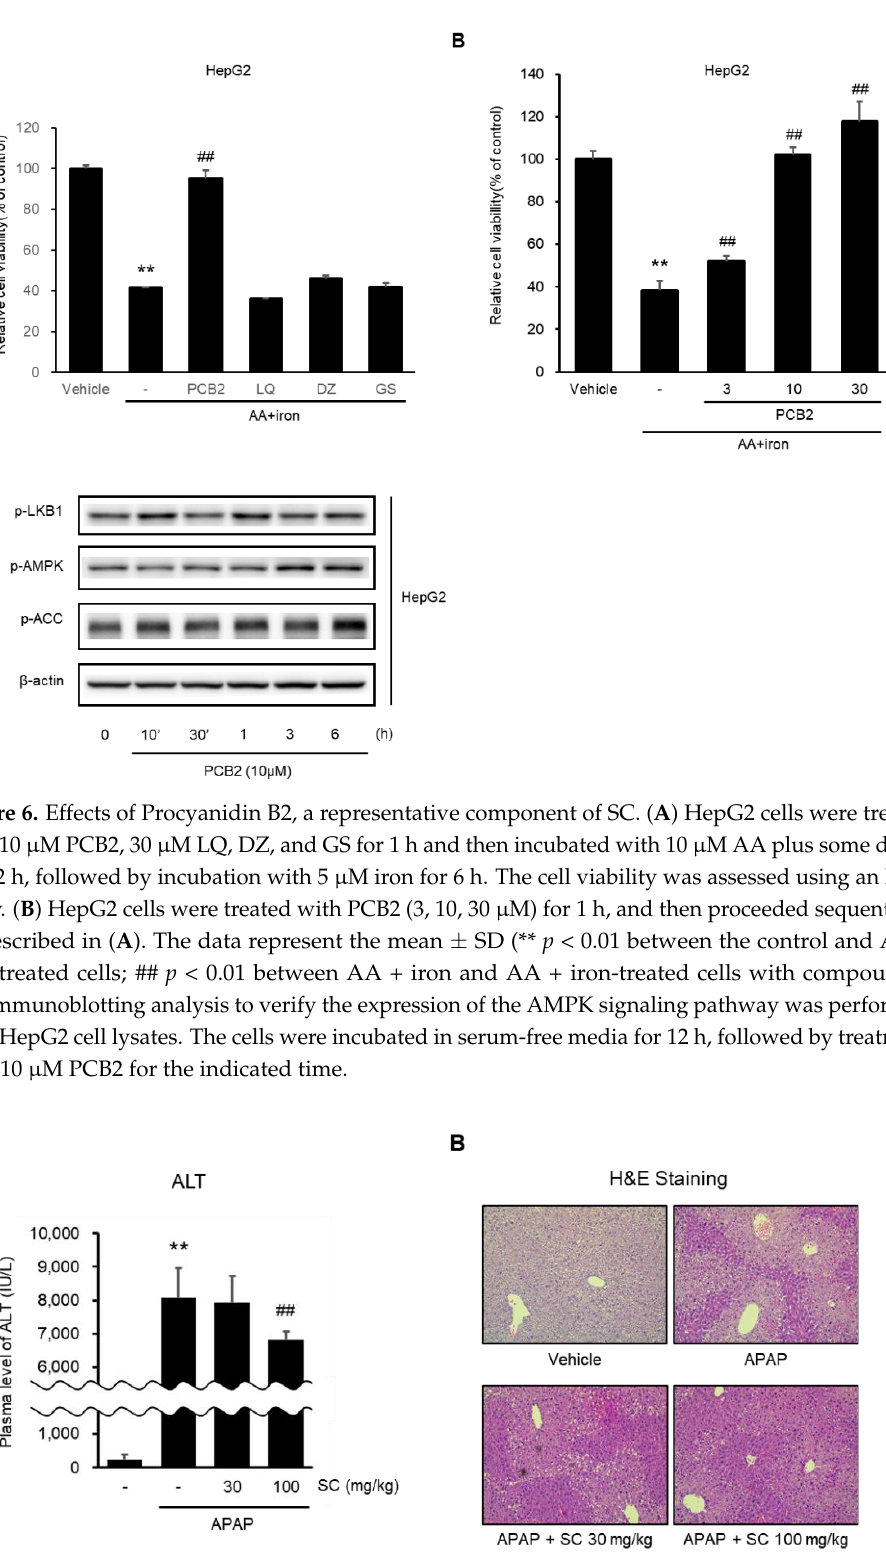
Figure 7. Effects of SC on APAP-induced liver injury and AMPK activation in mice. After the oral administration of 100 mg/kg SC to mice for three consecutive days, they were given a fasting time of 16 h. Subsequently, 500 mg/kg APAP was injected orally. ( A ) Serum ALT (alanine aminotransferase) levels in mice revealed changes in liver injury. The data represent the mean ± SD (** p < 0.01 between the vehicle control; ## p < 0.01 between APAP treatments). ( B ) Histochemical analysis of liver tissue in mice was performed by H&E staining (×200).